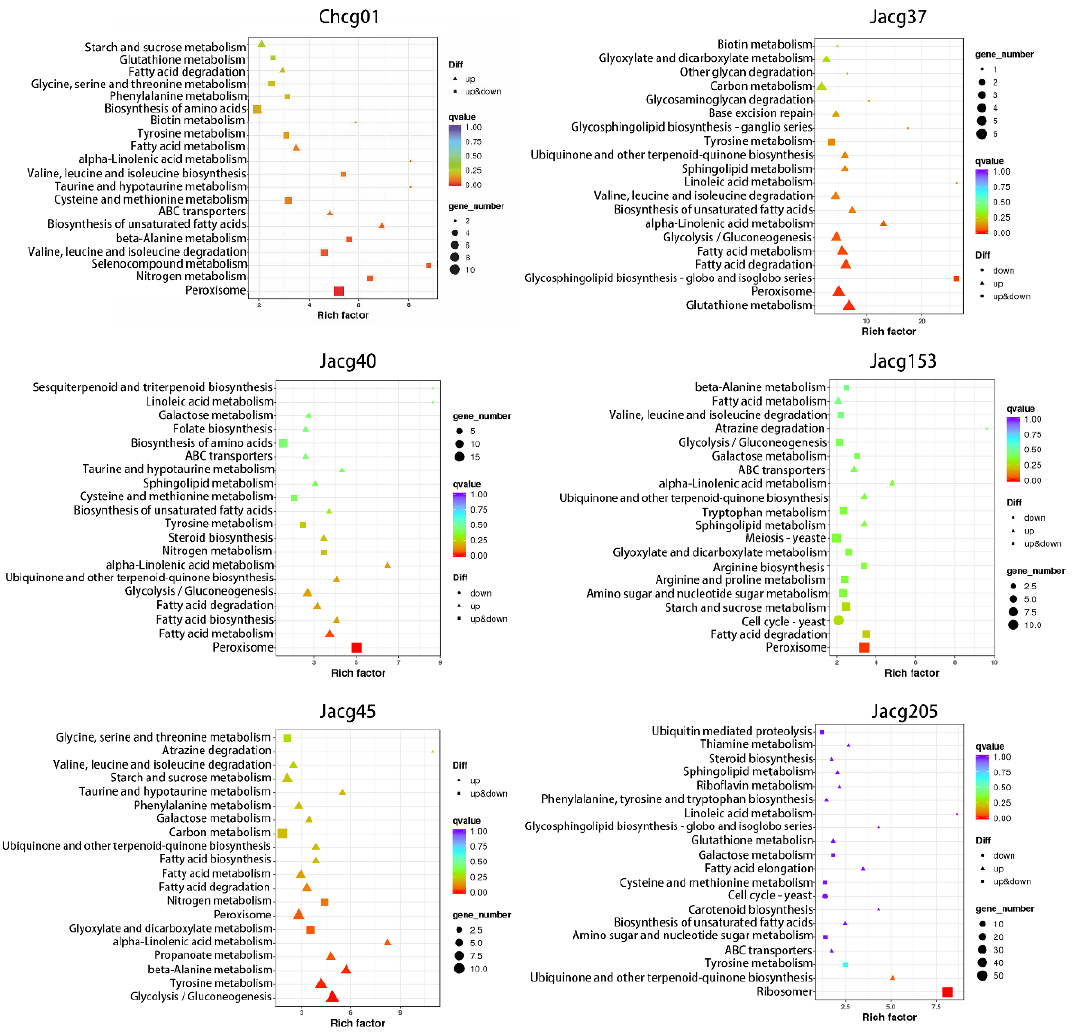
Figure 7. Kyoto Encyclopedia of Genes and Genomes (KEGG) enrichment analysis of the DEGs in six strains (Chcg01, Jacg37, Jacg40, Jacg45, Jacg153, and Jacg205) of Cenococcum geophilum after 10% PEG-6000 treatment compared to the control (0% PEG-6000). The size of the symbol represents the numbers of DEGs involved in the corresponding pathway.